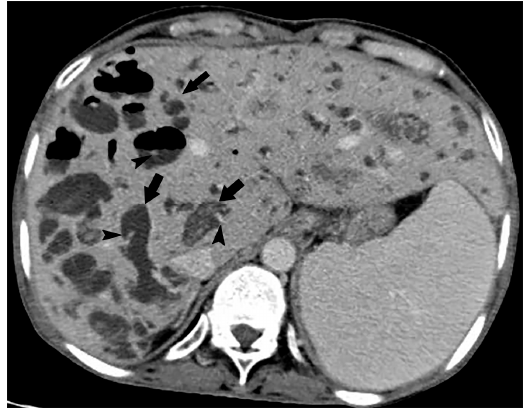
Figure 20. Caroli’s disease in a 58-year-old man. In the equilibrium phase on contrast-enhanced CT, multiple hypodense cystic or tube-like structures (arrows) are observed throughout the liver. Contrast-enhanced portal venous branches (arrowheads) are observed in the center of the hypodense structure, which is called the “central dot sign”, a characteristic finding of Caroli’s disease. Cancers 2020 , 12 , x FOR PEER REVIEW Schematic diagram of the pathological characteristics of BDN and its mimickers are shown on